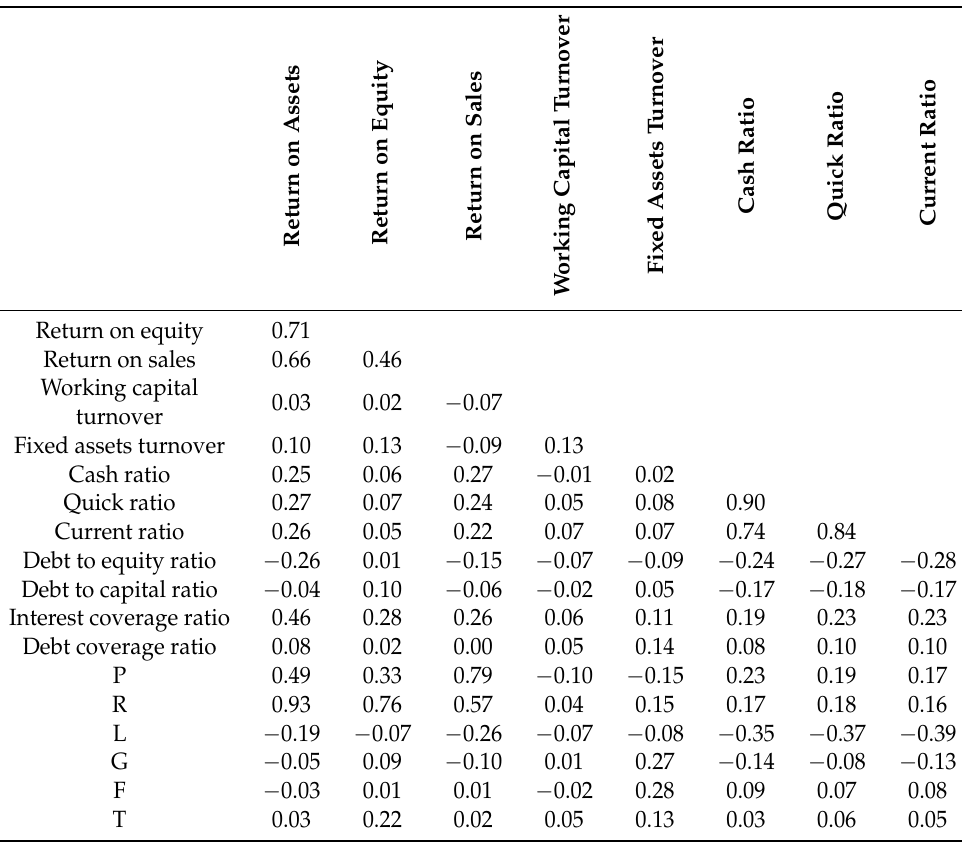
Table A1. Correlation matrix of additional indicators.